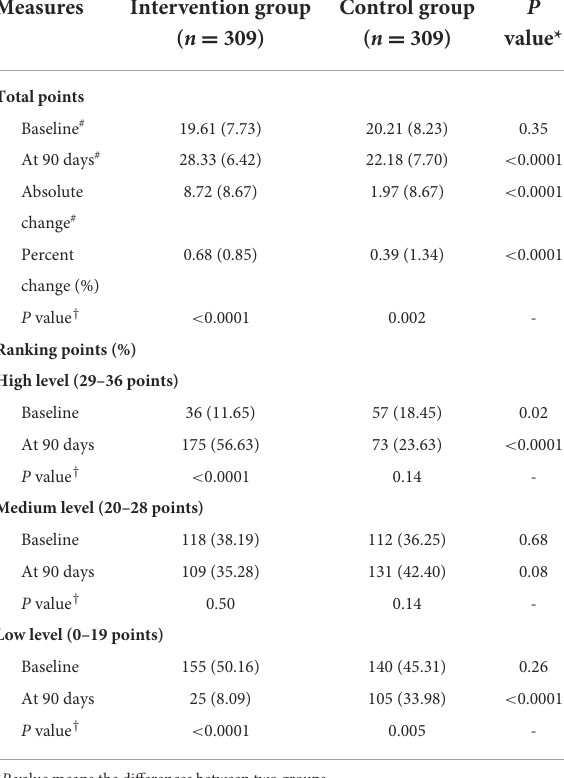
TABLE 6 The rational medication knowledge evaluation of elderly patients with multimorbidity.